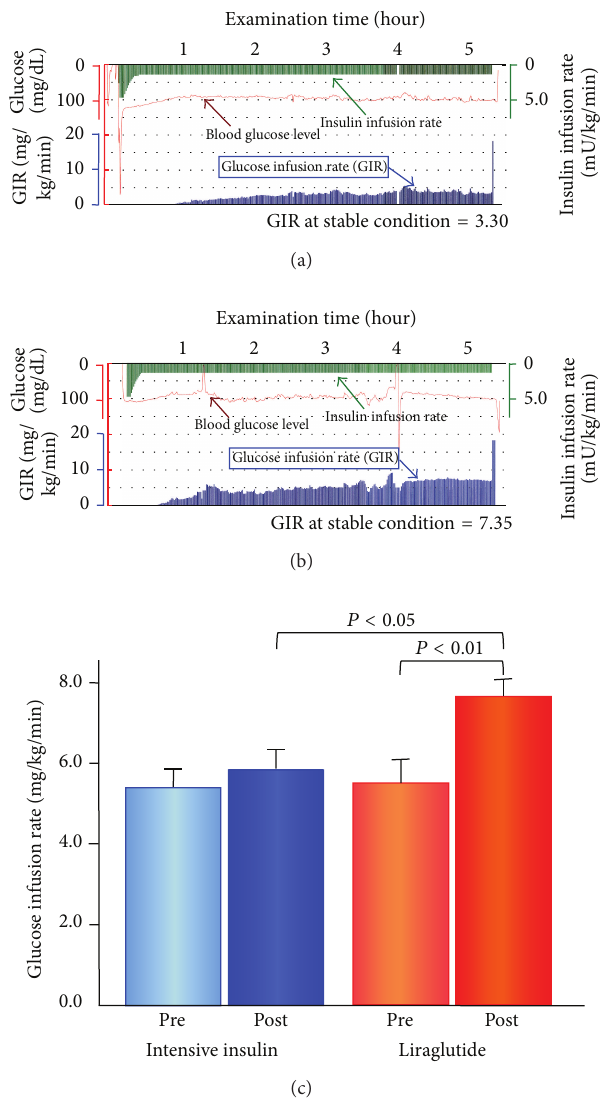
Figure 1: Glucose infusion rate in euglycemic-hyperinsulinemic clamp before and after the 4-week intensive insulin-therapy and liraglutide-therapy. (a) and (b) Representative records of measure- ment of glucose infusion rate during euglycemic-hyperinsulinemic clamp examination before and after the 4-week liraglutide- therapy. Real trace recordings demonstrate representative results of euglycemic-hyperinsulinemic clamp in a 77-year-old male with type 2 DM. He was treated by sulfonylurea before the introduction to liraglutide-therapy. His GIR value was increased from 3.30 (a) to 7.35 (b). (c) Actual measured values of the glucose infusion rate in euglycemic-hyperinsulinemic clamp before and after the 4- week intensive insulin-therapy and liraglutide-therapy. Bar graphs represent the actual measured values of the glucose infusion rate (GIR) of the mean and standard error of mean in patients with intensive insulin-therapy ( 𝑛 = 15 ) and liraglutide-therapy ( 𝑛 = 16 ). The intergroup comparisons of the posttreatment GIR values in liraglutide-therapy were significantly higher than those in intensive insulin-therapy (unpaired 𝑡 -test, 𝑃 < 0.05 ). The intragroup comparisons of the posttreatment GIR values were significantly higher than the pretreatment values in liraglutide-therapy (paired 𝑡 -test, 𝑃 < 0.01 ). Pre: pretreatment; Post: